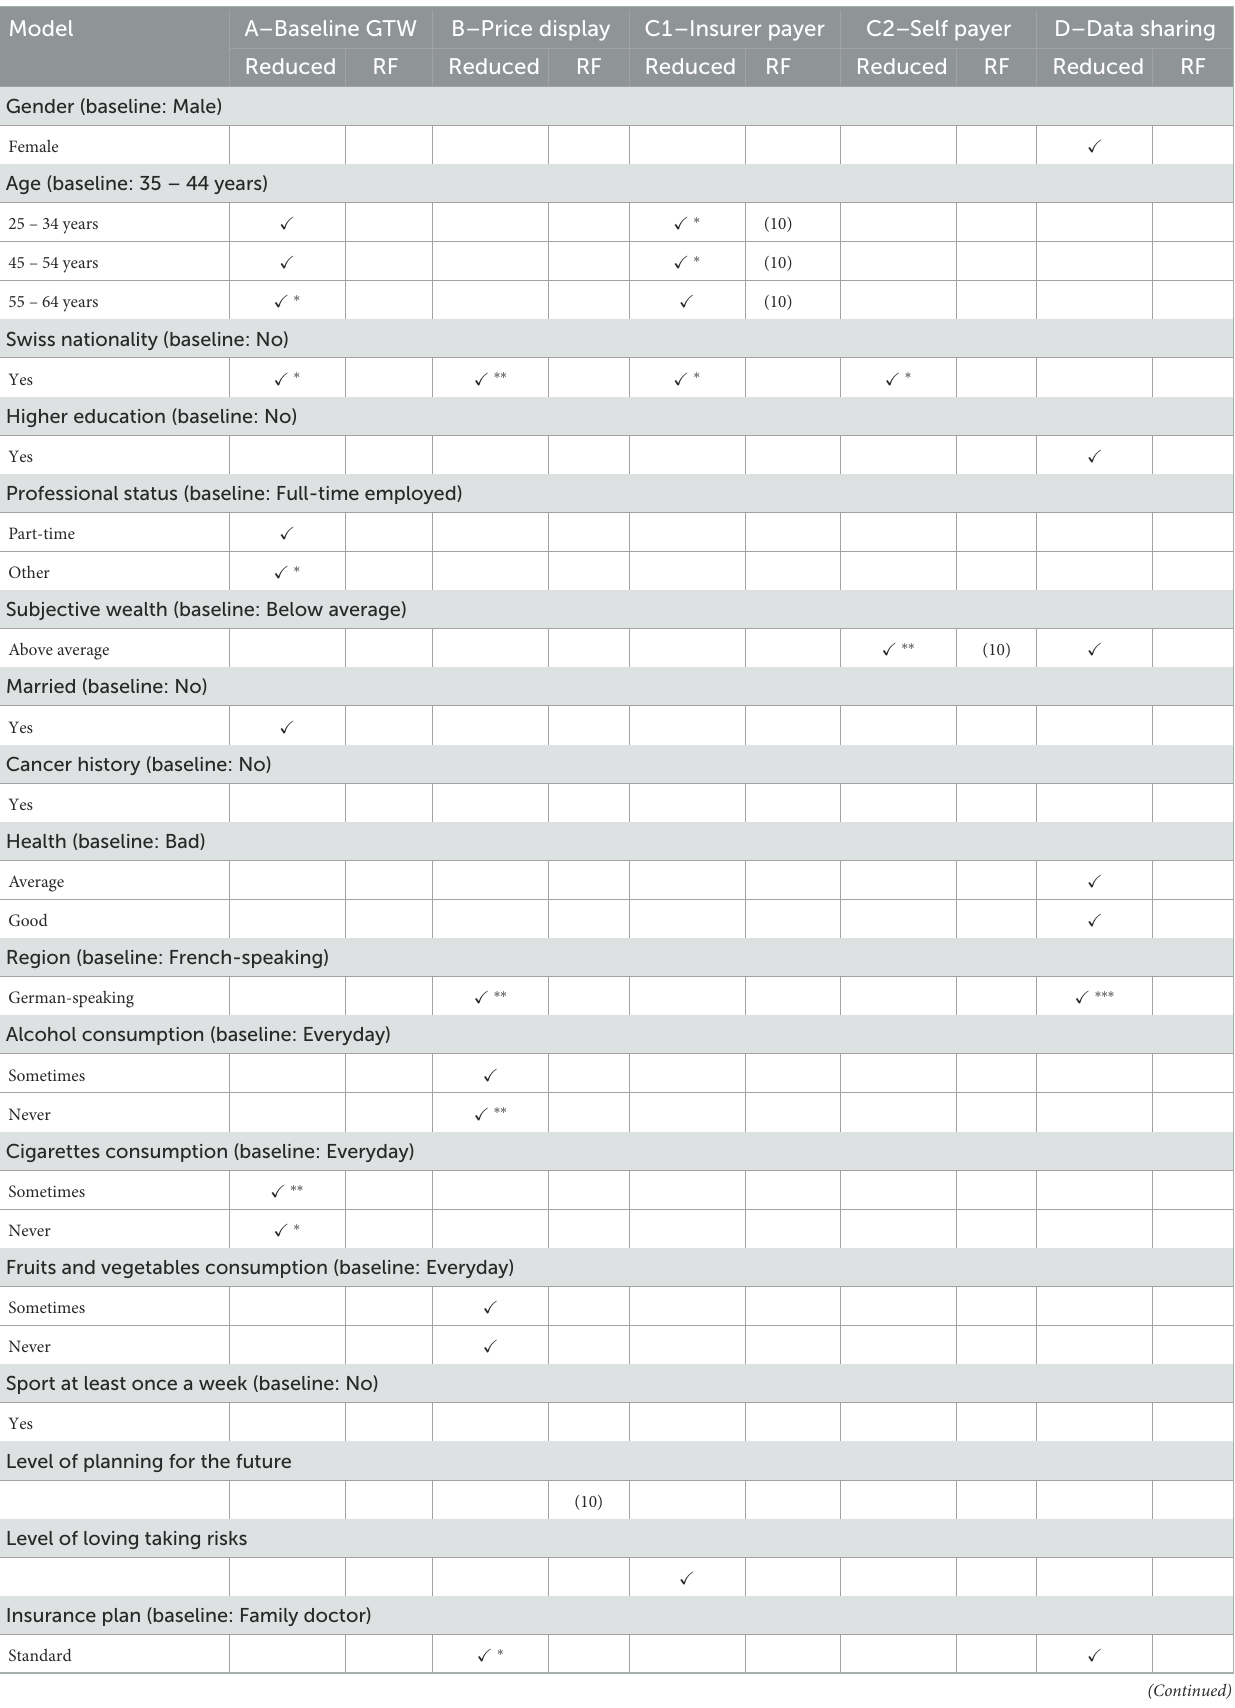
TABLE 13 Regression results for the reduced model and comparison with the variable ranking from random forest modeling. Model A–Baseline GTW Reduced RF Reduced RF Reduced RF Reduced RF Reduced RF